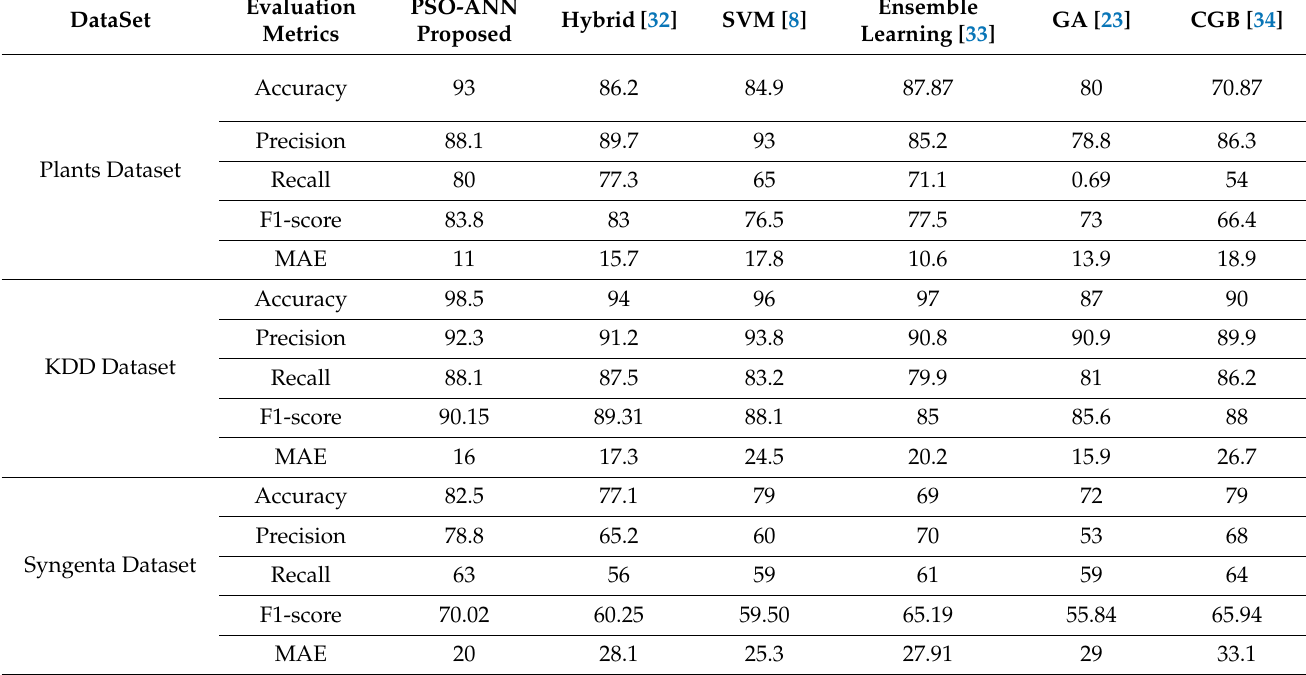
Table 4. Performance evaluation of the proposed PSO-ANN and other related classification